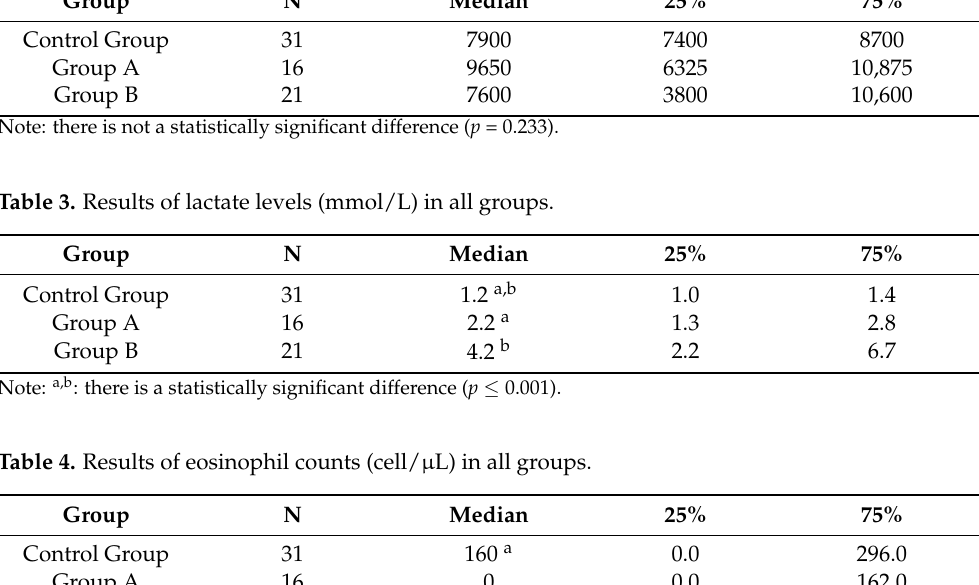
Table 2. Results of WBC counts (cell/ µ L) in all groups. Group N Median 25% 75% Control Group Group A Group B